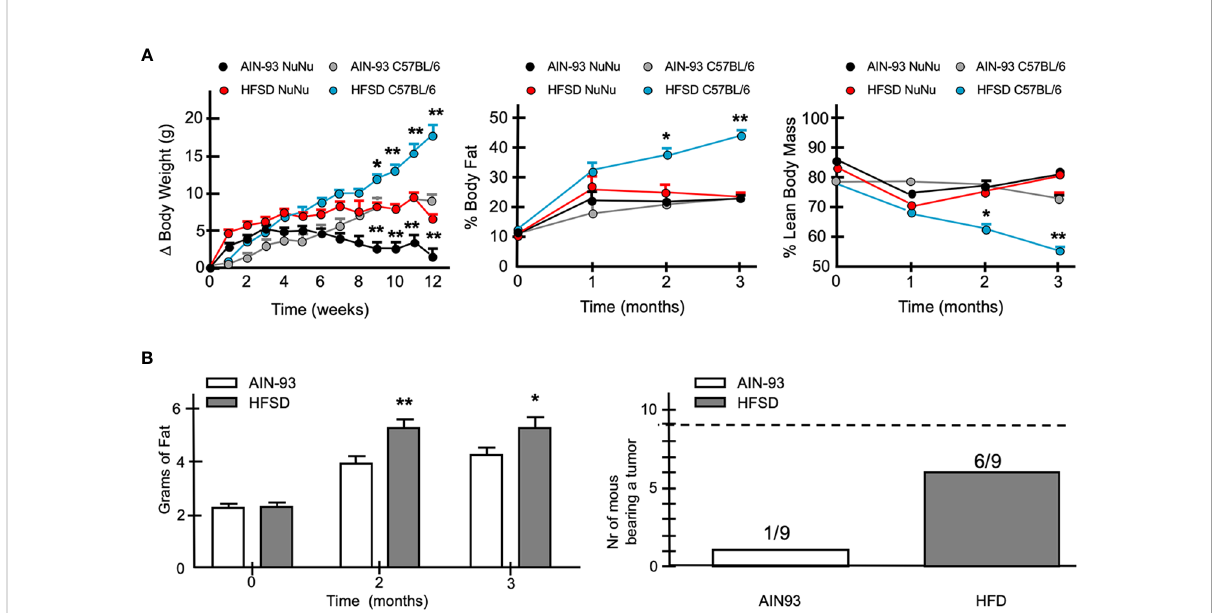
FIGURE 13 When fed a hypercaloric diet Nu/Nu female mice mimic a mild overweight condition and favor more frequent tumor development of DSG-BC- 2 xenotransplants. Tumorigenesis in female Nu/Nu mice fed with normocaloric (AIN93) o hypercaloric (HFSD) diet from weaning to the end of the tumorigenic assay. Animals were kept as described in materials and methods until they reached a weight of 20 g. (A) Increase in weight once they reached 20 g in Nu/Nu or C57B/6 female mice receiving AIN93 or HFSD (left panel), % of body fat (central panel) and % lean body mass (right panel). (B) Total weight estimated by NMR of Nu/Nu mice fed with the AIN93 or HFSD (left panel). Number of the mice bearing tumors from a total of 9 mice that received 20 x 106 cell of the DSG-BC2 that were fed with either AIN93 or HFSD (right panel); n = 9, p value < 0.05 (*) or a p value < 0.01